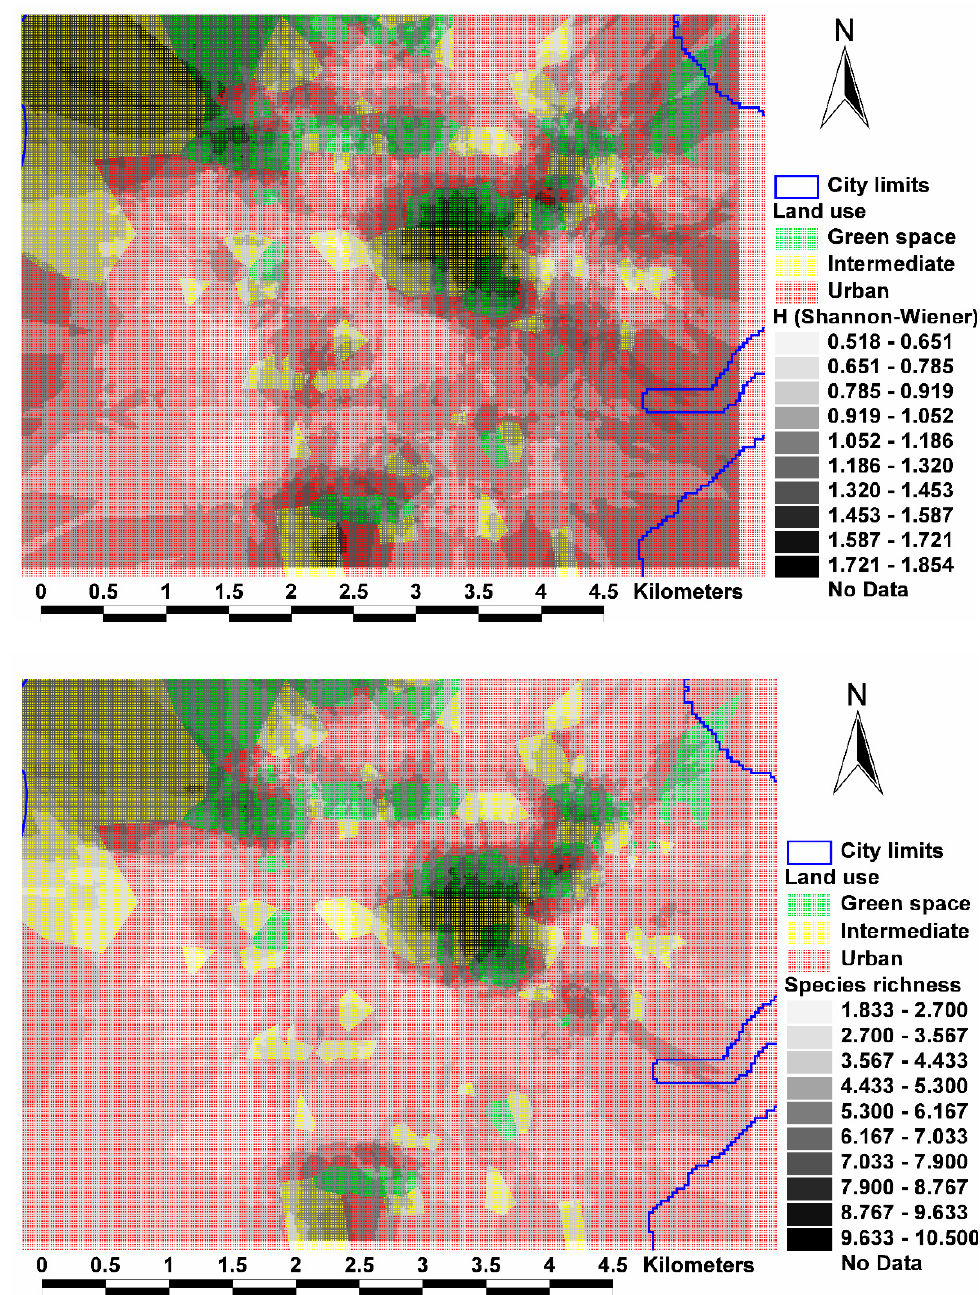
Figure 4. Interpolated spatial distribution of Shannon-Wiener’s informational entropy index ( top ) and species richness ( bottom ) and interpolated land cover and use in Annaba, Algeria. The darker shades correspond to higher values of the two indices, indicating higher biodiversity.